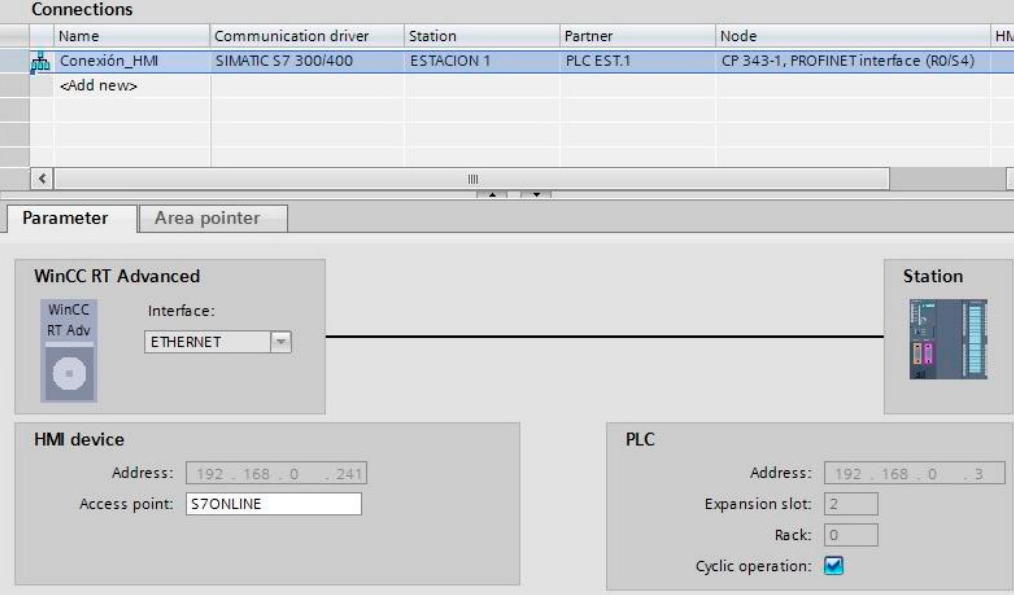
Figure 16. Network View of TIA Portal including PROFIBUS and Ethernet networks. 4. Results and Discussion In this section, the achieved results are expounded and discussed. Once the Ethernet connection and the DB structure have been configured, all the operational information of the S&A network and of PLC is available to be monitored. To this aim, a SCADA system has been developed and deployed, demonstrating the feasibility of the proposed approach. Furthermore, a database has also been generated to afford this information to other software applications. 4.1. SCADA System As briefly indicated in the Introduction, a SCADA system is a software application specially designed to work on computers in production control, providing communication with field devices (S&A, PLC, etc.) and controlling the process automatically from the screen. It also provides all the